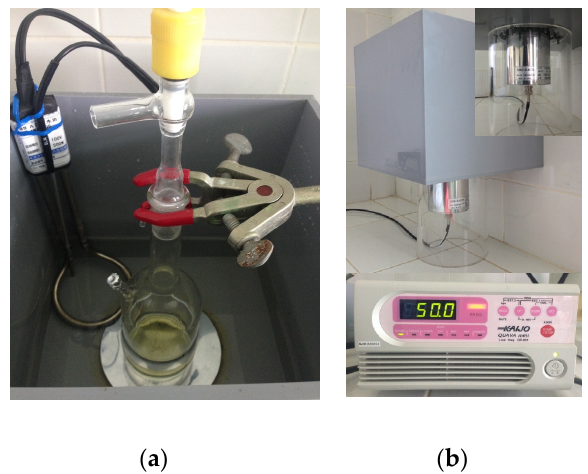
Figure 1. The reaction vessel placed on the transducer in a temperature controlled water bath ( a ) and the planar type of transducer and its controller ( b ).